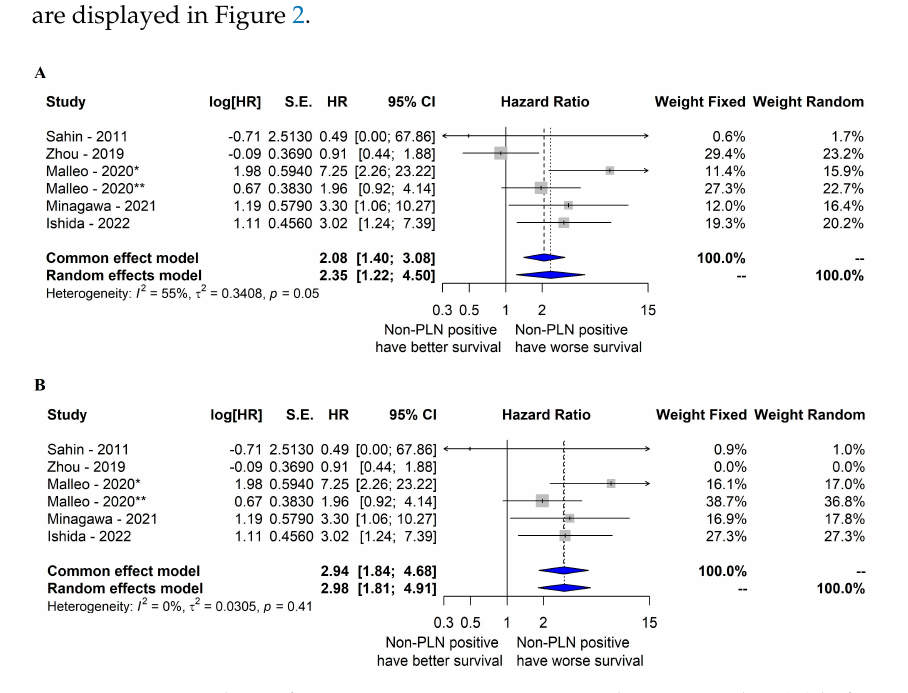
Figure 2. Meta-analysis of generic inverse variance: mortality. Forest plots ( A ) before and ( B ) after sensitivity analysis. * LN station 9; ** LN station 8.